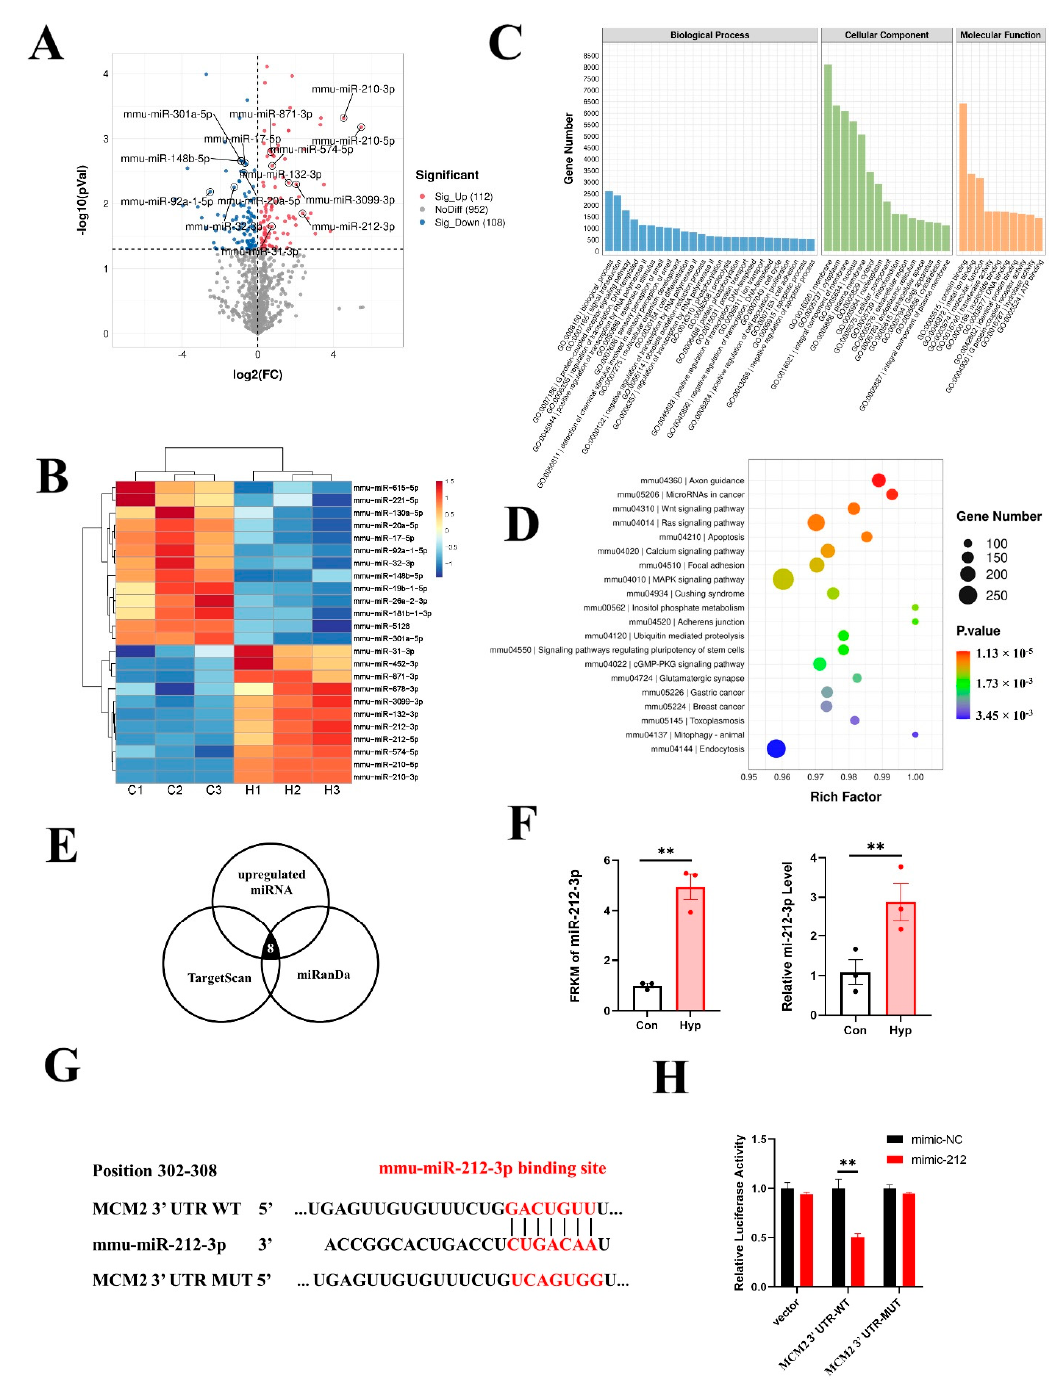
Figure 5. miR-212-3p directly downregulates MCM2 in microvascular endothelial cells under hy- poxia. ( A ) Volcano map of differentially expressed miRNAs between the control and hypoxia groups. ( B ) Heatmap of the top upregulated and downregulated miRNAs. ( C ) GO term analysis of target genes for differentially expressed miRNAs. ( D ) KEGG pathways analysis of target genes for differentially expressed miRNAs. ( E ) Venn diagram of significantly upregulated miRNAs targeting MCM2. ( F ) Expression of miR-212-3p from RNA-seq data and qRT–PCR ( n = 3). ( G ) Schematic diagram of the predicted binding sequences of miR-212-3p to the MCM2 3’UTR WT or MUT. ( H ) Luciferase activity was detected by dual luciferase assay after cotransfection of MCM2 3 (cid:48) UTR-WT/MUT as well as miR-212 mimic and mimic NC in 293T cells. Data are shown as the mean ± SEM, ** p <